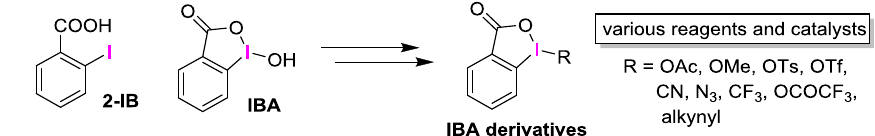
Figure 1. 2-Iodosobenzoic acid (IBA) and its precursor 2-iodobenzoic acid (2-IB). Although IBAs can be prepared from 2-IBs by existing methods (Figure 2) [63–66], the development of a safer and more efficient method for their synthesis is highly